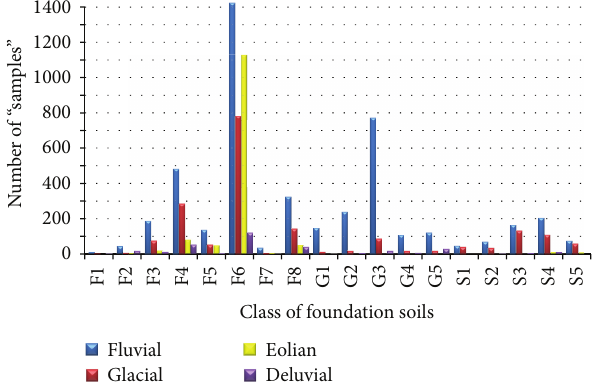
Figure 4: Number of the studied samples of different genetic types in the individual foundation soil classes.